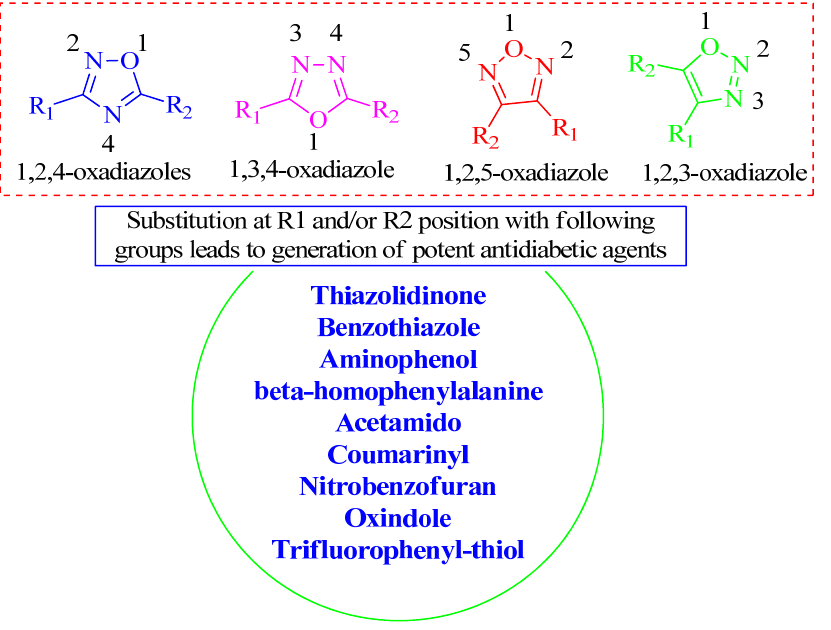
Figure 24. Predicted SAR of oxadiazoles .